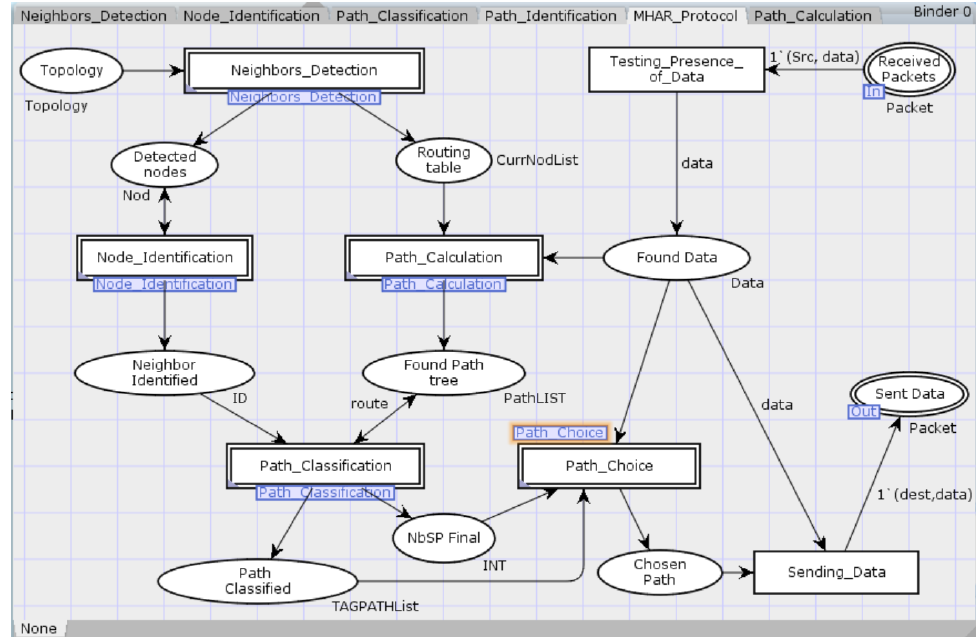
Figure 2. MHAR algorithm model.